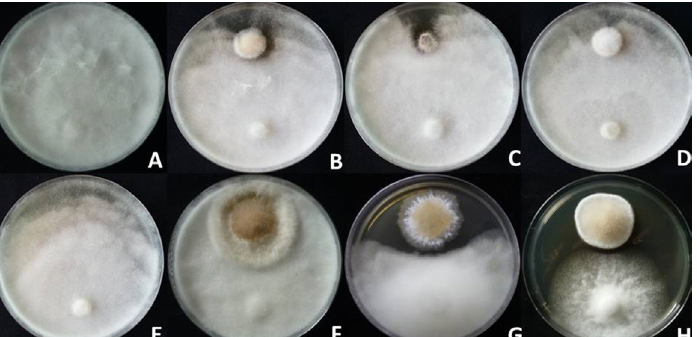
Fig. 2. Efficacy of Cyathus sp. controlling Pythium aphanidermatum . Top- Placing Cyathus sp. and P. aphanidermatum on same day. Bottom- Placing Cyathus sp. four days before P. aphanidermatum . A,E: P. aphanidermatum B,F: P. aphanidermatum + C. striatus KKU1 C, G: P. aphanidermatum + C. earlei KKULP1 D, H: P. aphanidermatum + C. stercoreus